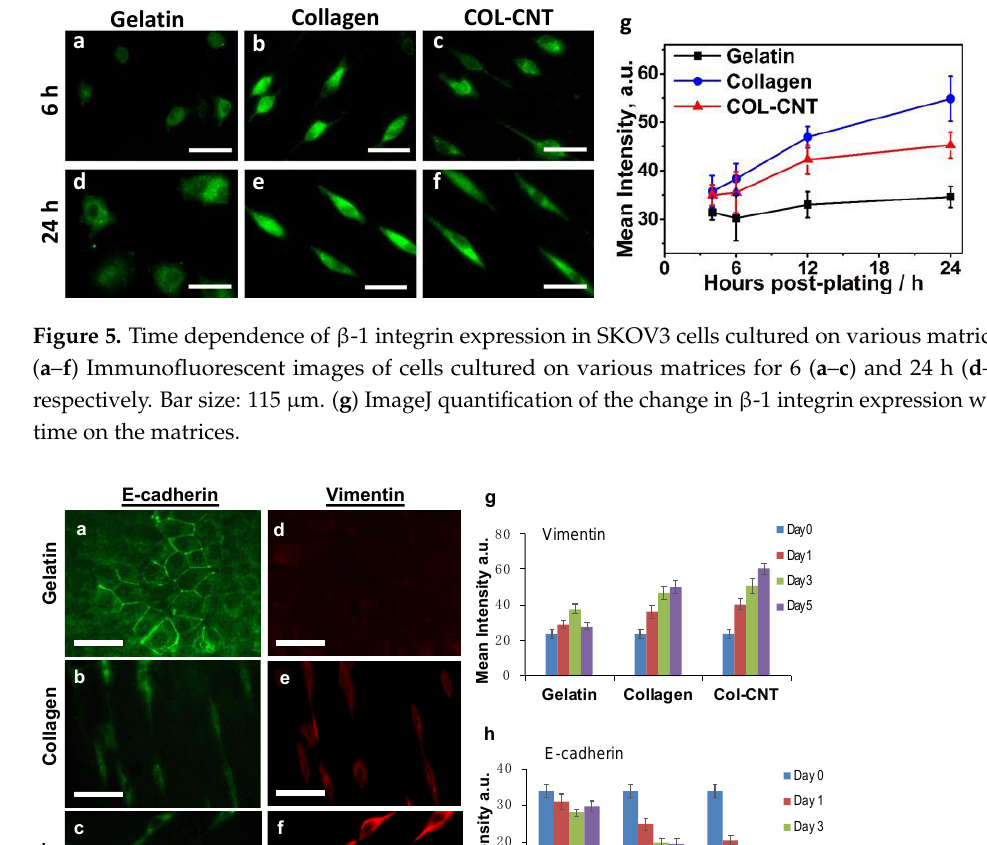
Figure 5. Time dependence of β-1 integrin expression in SKOV3 cells cultured on various matrices. ( a – f ) Immunofluorescent images of cells cultured on various matrices for 6 ( a – c ) and 24 h ( d – f ), respectively. Bar size: 115 μm. ( g ) ImageJ quantification of the change in β-1 integrin expression with time on the matrices.